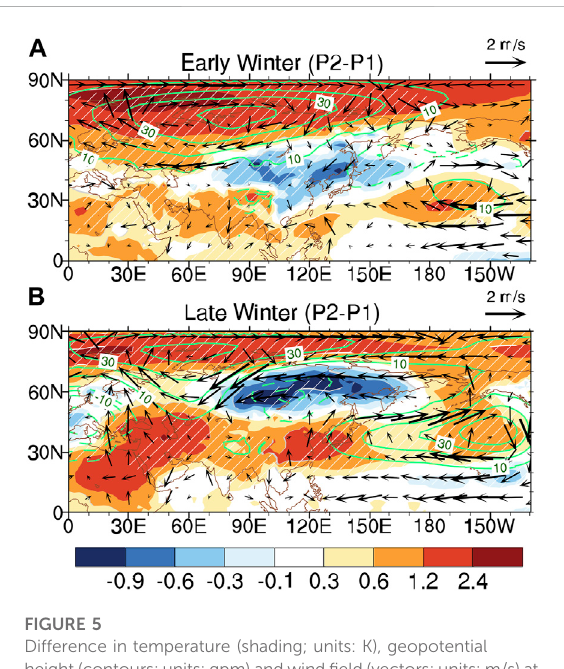
FIGURE 4 Difference in the geopotential height (shading; units: gpm) and wind fi eld (vectors; units: m/s) at 500 hPa between P2 and P1 (P2 − P1) in (A) early and (B) late winter. The green lines represent the average geopotential height in early and late winters of P2, which are 5150, 5250, 5350, 5450 and 5550 gpm, respectively. The white slanted lines represent p < 0.05.